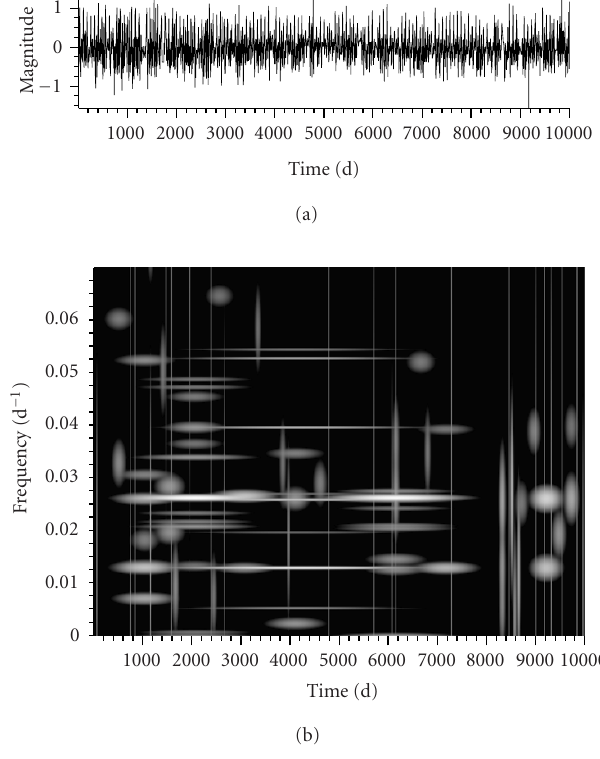
Figure 15: Time-frequency decomposition (b) of the AC Herculis signal (a).